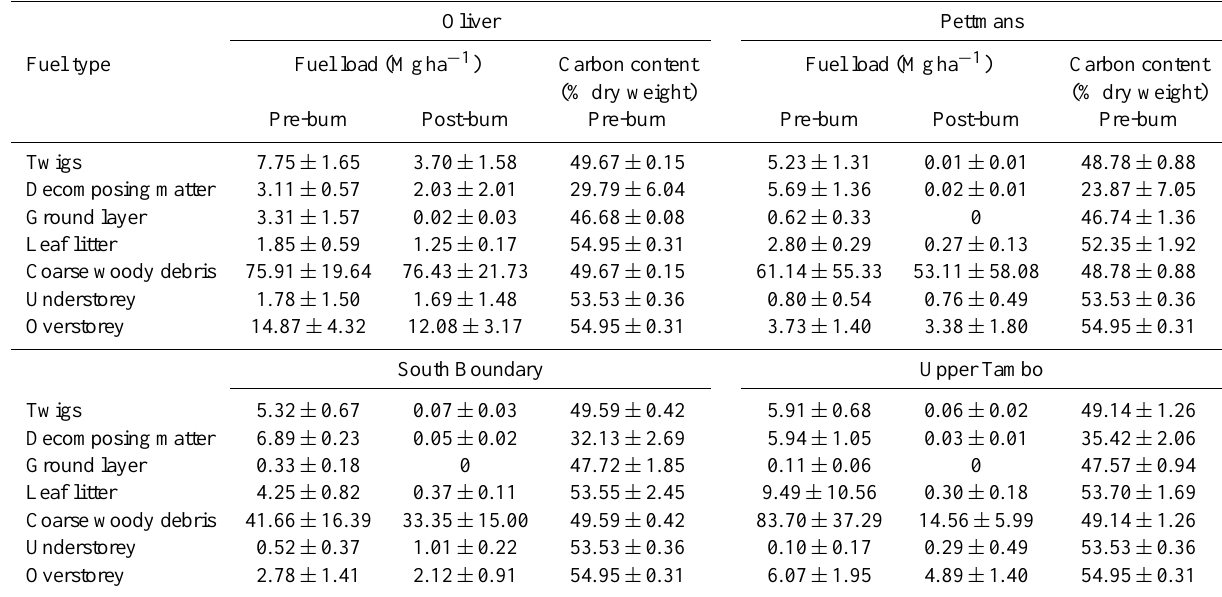
Table 2. Fuel load and pre-burn carbon content of a range of fuel types measured before and after fire in four forest sites in East Gippsland, south-eastern Australia. Values are mean ± standard deviation ( n =